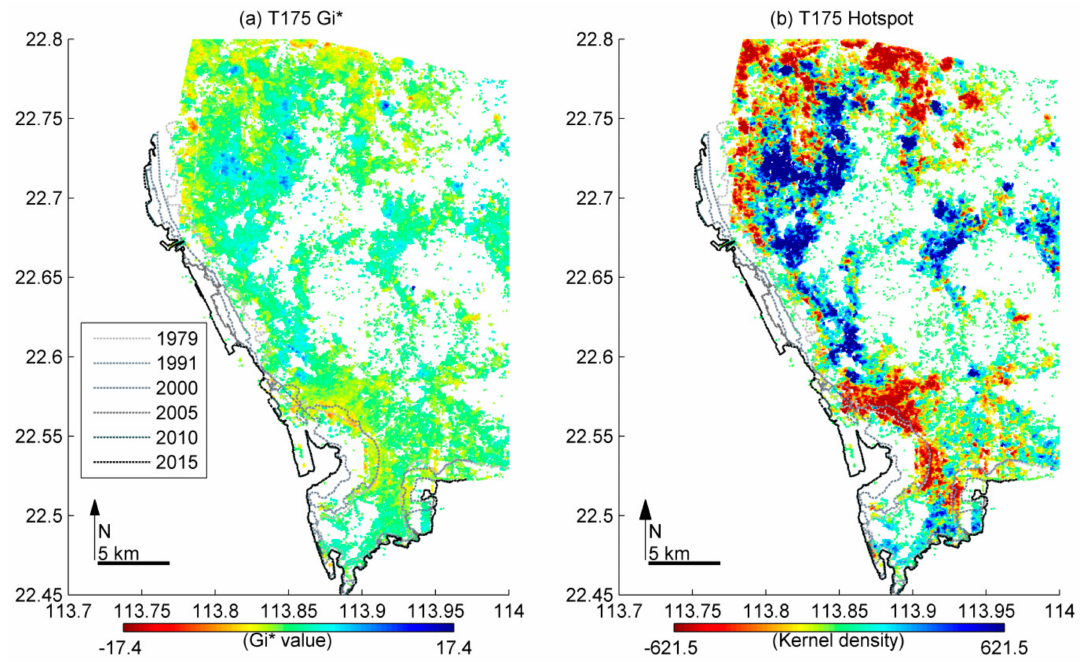
Figure A1. The clustering of mean rates using Getis–Ord Gi* statistic for ASAR T175. ( a ) Gi* values; ( b ) Hotspot map derived from a kernel density estimation.